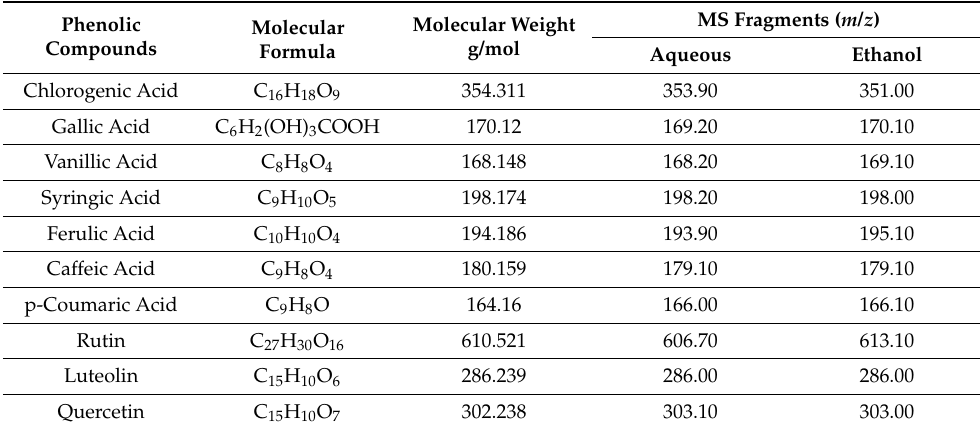
Table 1. GC/MS analysis of Phenolic constituents of the Palm leaves